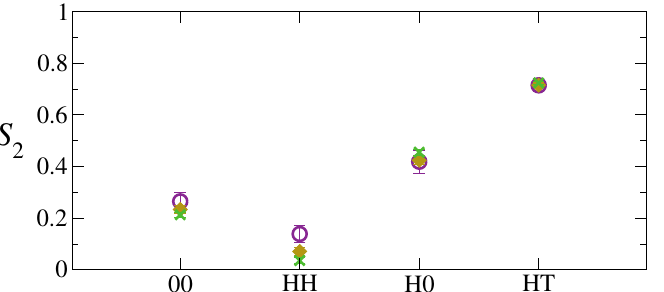
Figure 7. Nematic order parameter at mass fraction values 1wt% (empty purple circles), 5wt% (yellow diamonds) and 10wt% (green crosses).